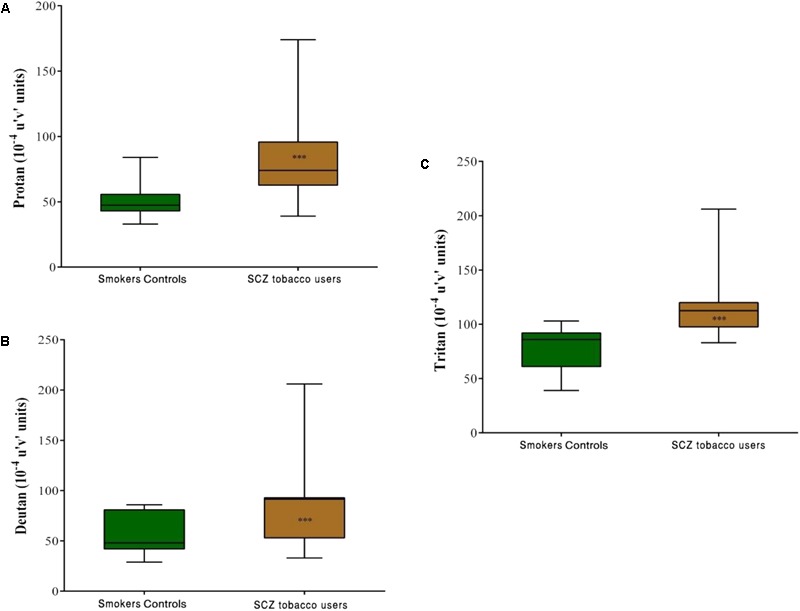
Trivector test, showing boxplots for protan (A), deutan (B), and tritan (C) confusion lines. The data are presented in 10-4 u’v’ units. Each boxplot is based on the results of 40 participants in the smoker controls (SC) group and 20 participants in the schizophrenia (SCZ) tobacco-user group. ∗∗∗p < 0.001.